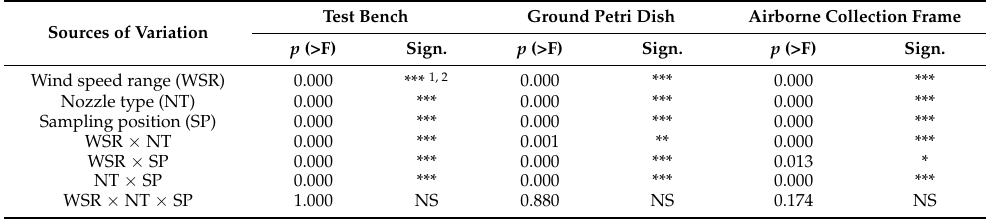
Table 3. Significance obtained from three-way ANOVAs for DPs as affected by wind speed, nozzle type, and sampling position (downwind distance or height above the ground) using UASS based on test bench, ground petri dish, and airborne collection frame.